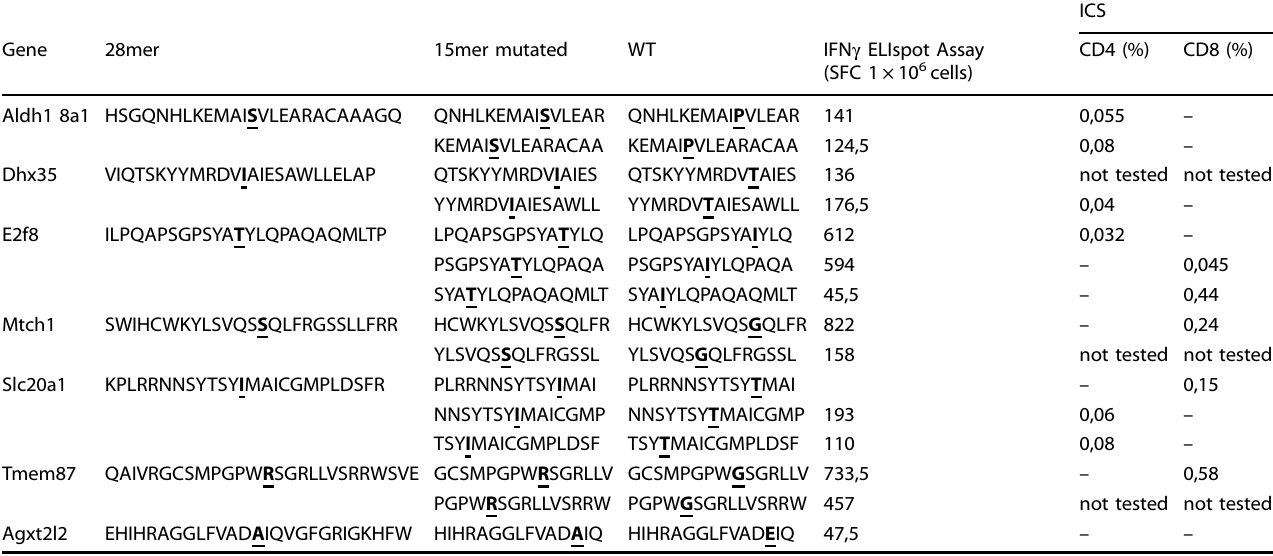
Table 2. Immunogenic neoantigens expressed by C20